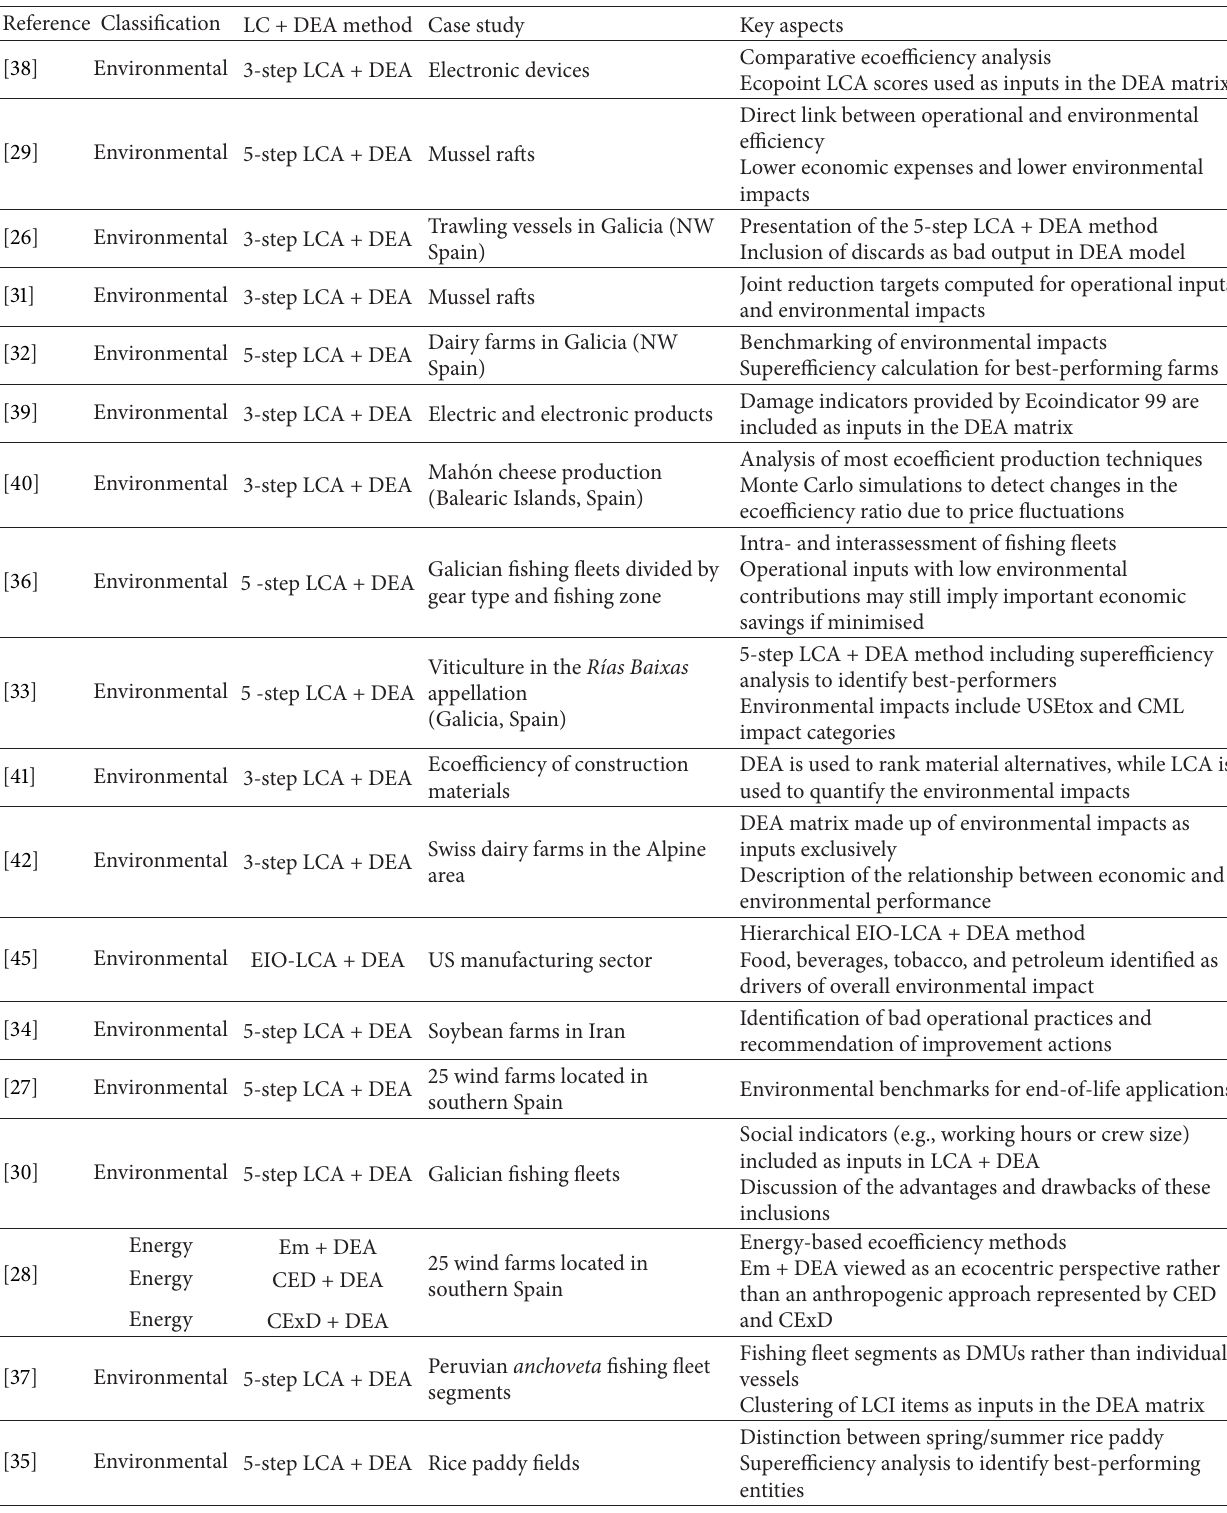
Table 1: List of case studies currently available in the literature using LC + DEA